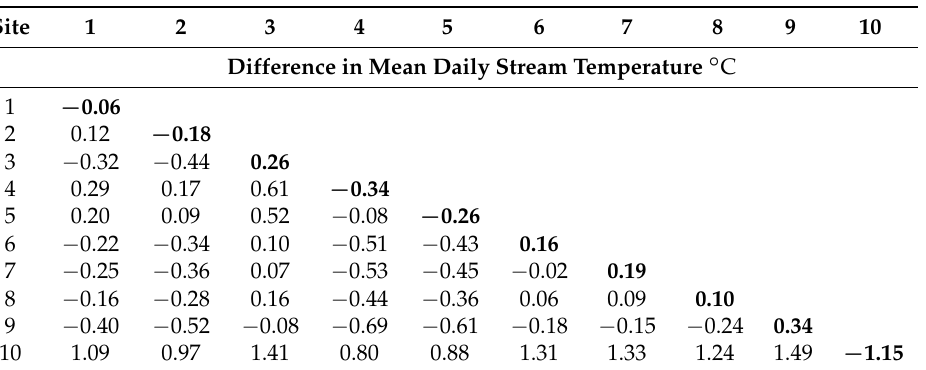
Figure 4. Regression parameters for the relationship between mean daily stream temperatures and mean daily air temperatures (black) and maximum daily stream temperatures and maximum daily air temperatures (greay) at each site. Parameters were estimated using Bayesian regression analyses. Points indicate mean value of regression parameter ( µ β and µ α ), solid lines indicate 67% confidence level, and + indicates 95% confidence level ( σ β and σ α ). Intercept is ◦ C where an intercept = 0 ◦ C (dark dotted line) indicates that the mean (maximum) daily T s at a basin is the same as the mean (maximum) stream temperature for all basins combined over the period of record. Mean daily and maximum stream temperature was used as the baseline to calculate anomalies for mean daily and mean daily maximum stream temperatures at each basin. Table 5. Mean daily temperature anomaly ( ◦ C) at each site. Diagonal of matrix (bold) is the temperature anomaly for the site based on all sites combined. Other values are the difference of the mean daily temperature anomaly between each site. Positive values indicate that the mean daily temperature at the site listed in the column is greater than the site listed in the row (all sites combined for bold values). All values were statistically significant ( p < 0.001); however, differences within ± 0.4 ◦ C are not considered physically significantly different due to the error in the data